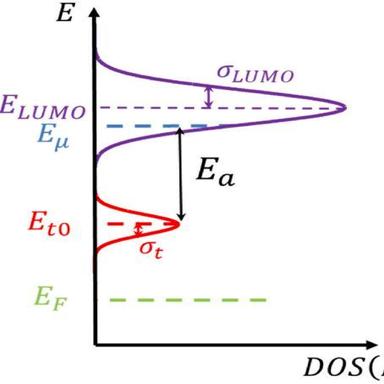
Schematic of the energy distributions for electrons in OSC: a Gaussian DOS for the mobile electrons, a Gaussian distribution for the trapped electrons. The position of the Fermi level is the one that corresponds to the trap relaxation phase.